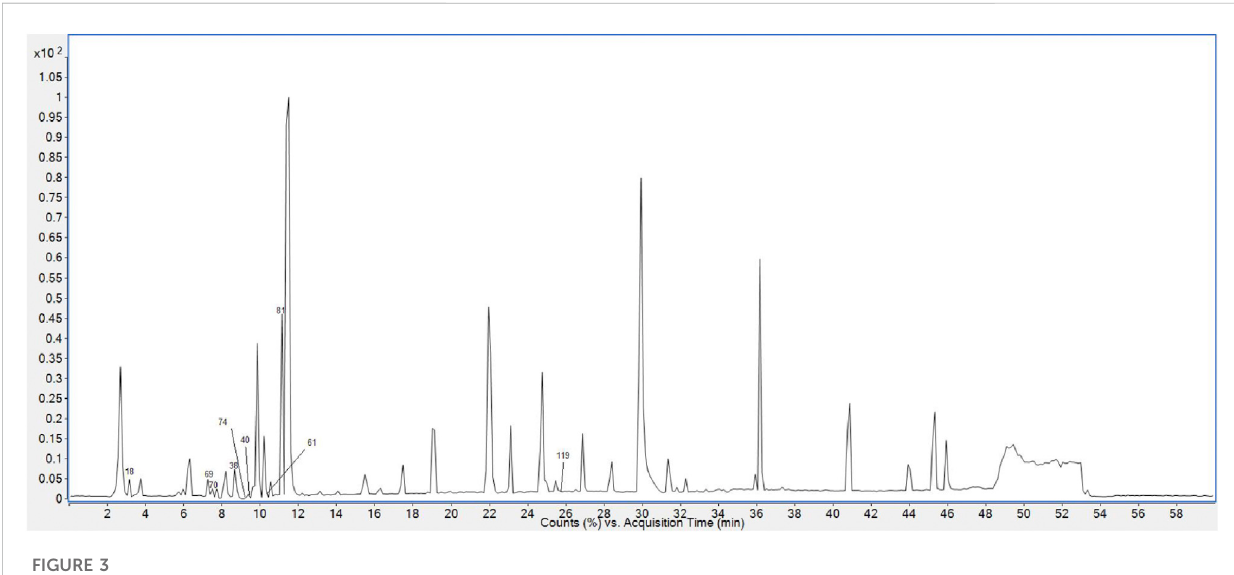
FIGURE 3 BPC of PMR 95% ethanol